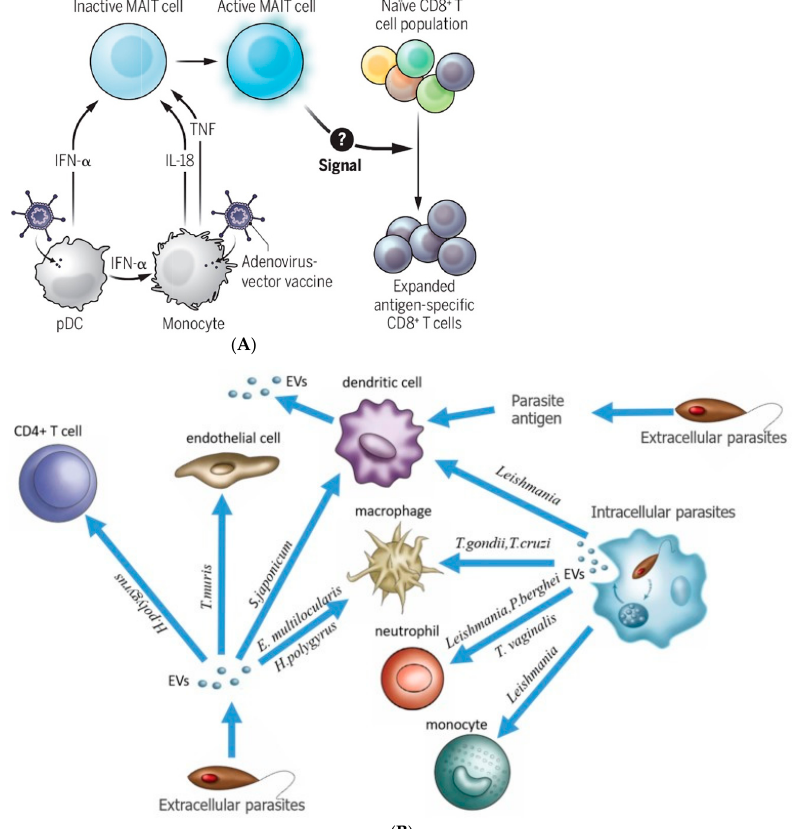
Figure 6. Communicating vaccine immunogenicity derived from three EV production modes associated with parasitic infection. ( A ) Adenoviral vaccine acts on pDCs and monocytes to produce IFN- α , IL-18, and TNF to activate MAIT cells, which might produce EVs (our hypothesis) to expand vaccine antigen-specific CD8+ T cells [73]. We speculate that the signal in question (with a question mark) is carried by exosomes or microvesicles, including caveolae-mediated extracellular vesicles (EVs), as proposed here. ( B ) Three EV production modes are associated with parasitic infection [23]. [Figure reproduced from [47] with the permission of Science—the AAAS Publishing].